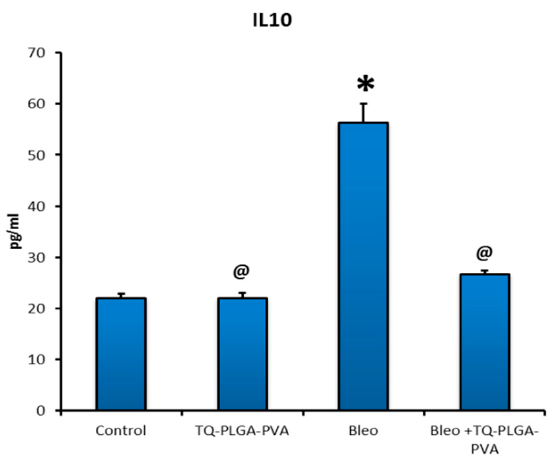
Figure 4. The effect of TQ-PLGA-PVA-NPs on levels of interleukin10 (IL 10) in bleomycin-induced pulmonary fibrosis in rats’ lungs. Results are presented as means ± SEs. Statistical analyses were achieved using one-way ANOVA followed by Duncan’s multiple range test; * p < 0.05 compared with the normal control. @ p < 0.05 compared with the bleomycin-treated rats.